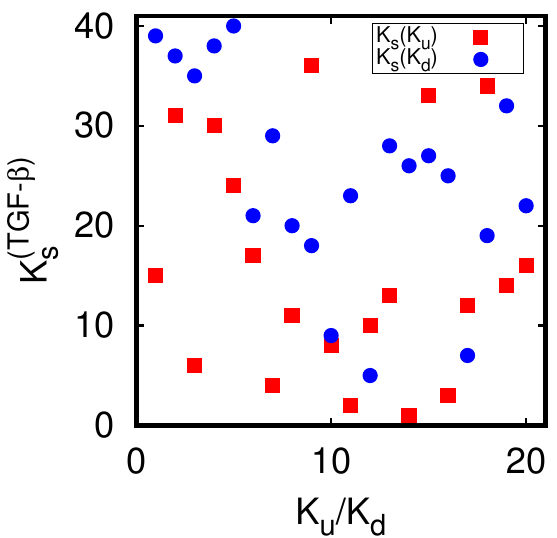
( TGF − β ) Figure A4. Effective ranking K s index of the TGF- β sensitivity versus K u / K d of up- (red boxes) ( TGF − β ) and down-proteins (blue full circles). The ranking index K s is determined by ordering the ( TGF − β ) ( a ) = ∑ 4 D ab in decreasing order for a = 5, . . . ,44 (i.e., a belongs to one of the sets sum D s b = 1 of up- or down-proteins) and where D ab is the sensitivity matrix for the 54 nodes of Table 1 (see also Figure 5).